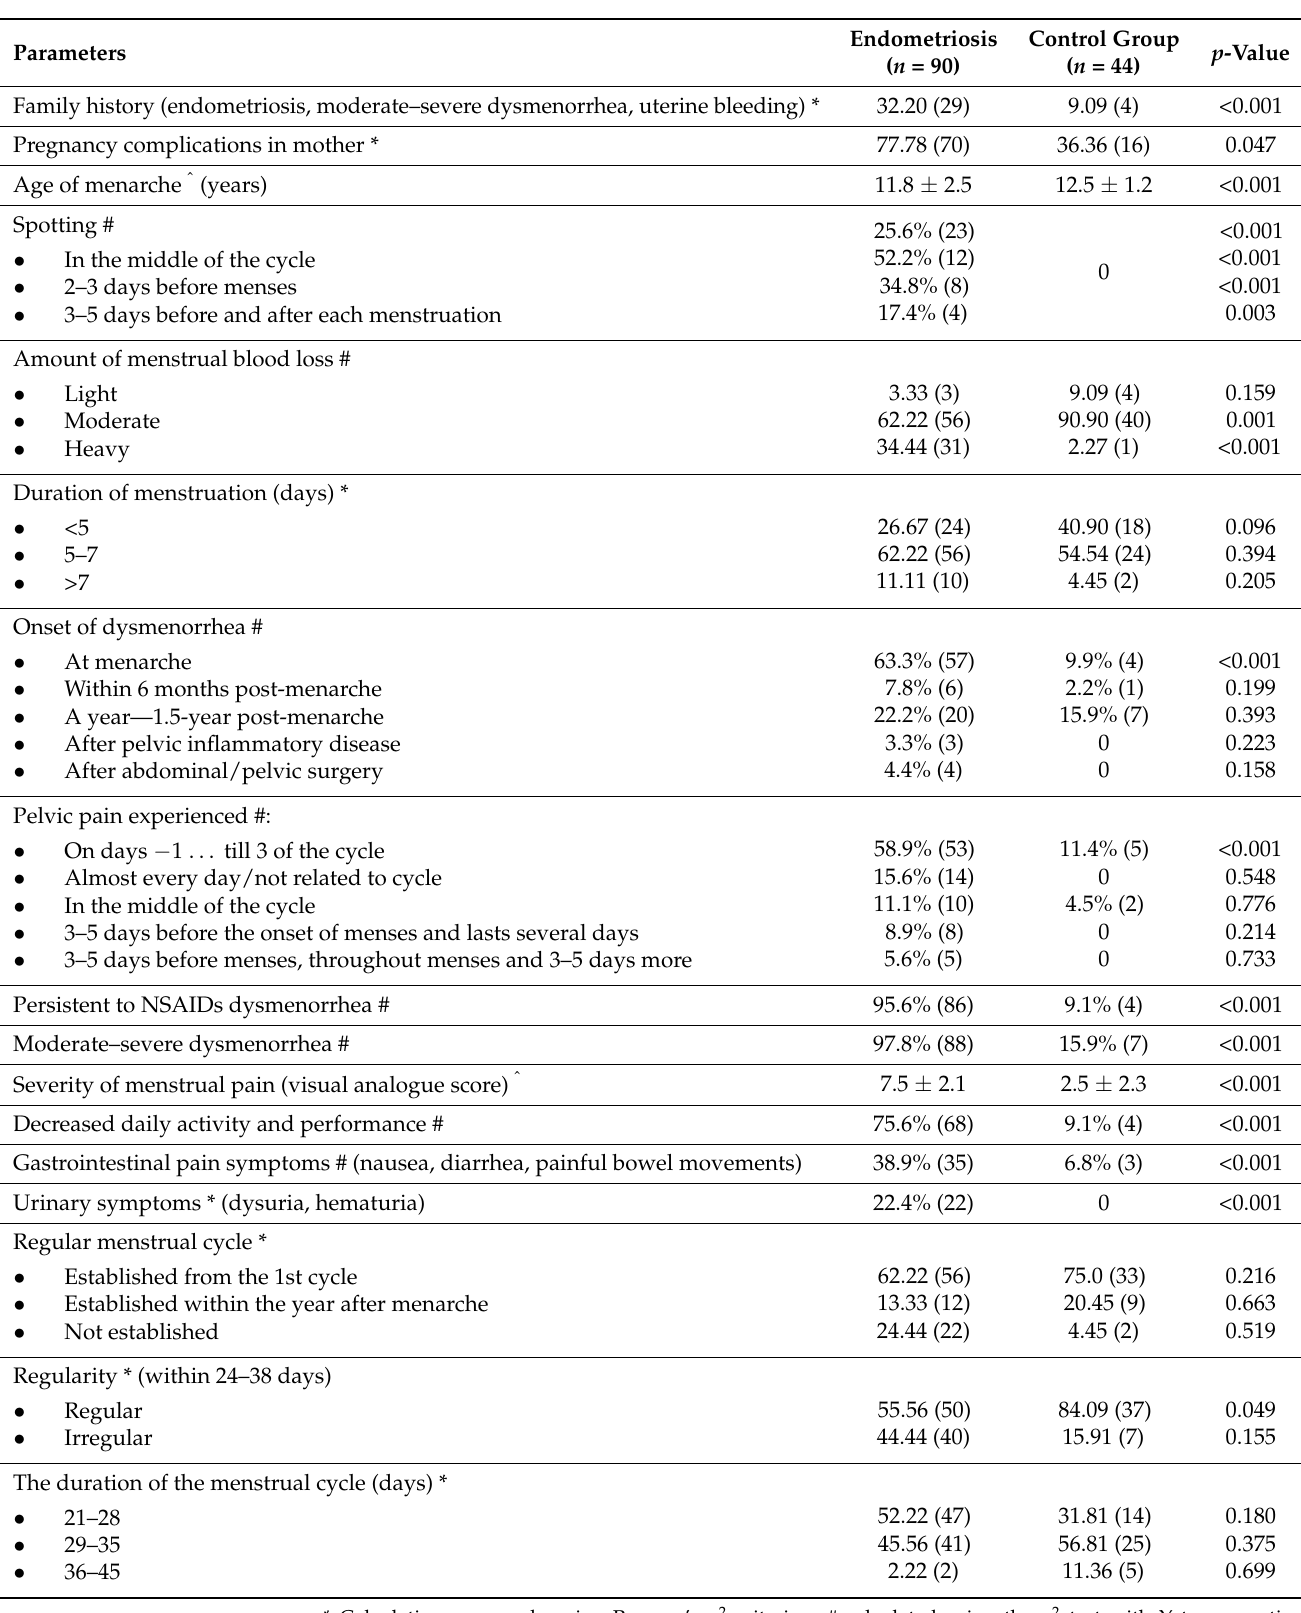
Table 1. Anamnesis, menstrual cycle and clinical characteristics in adolescents with endometriosis and “healthy”